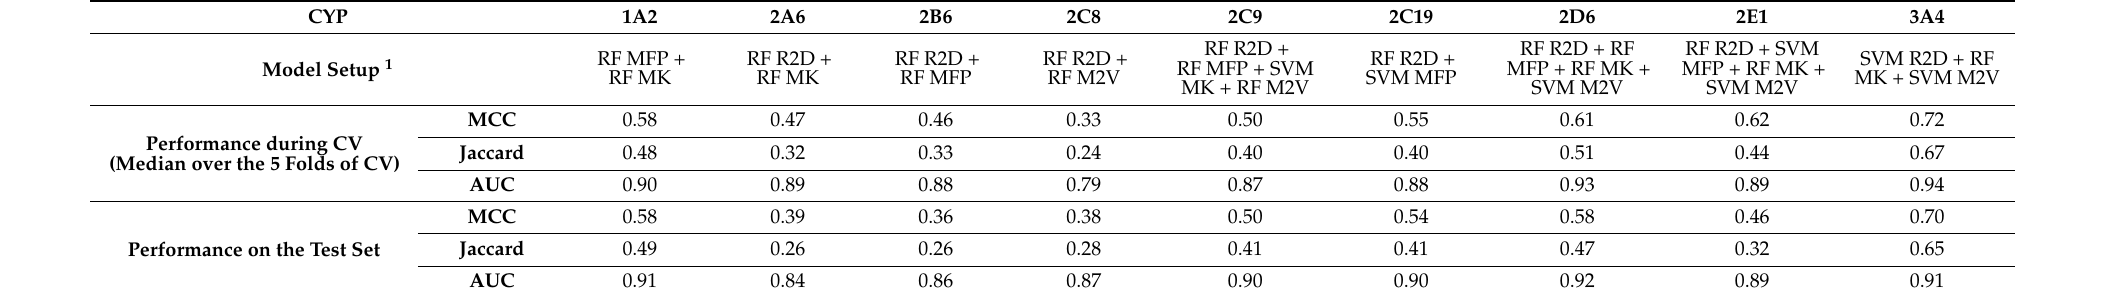
Table 4. Performance of the best-performing soft voting classifiers by MCC.